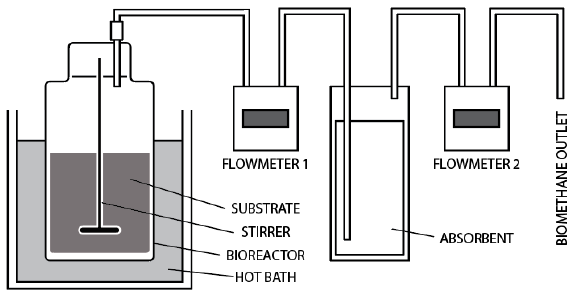
Figure 2. Laboratory scale biogas and biomethane reactor scheme.